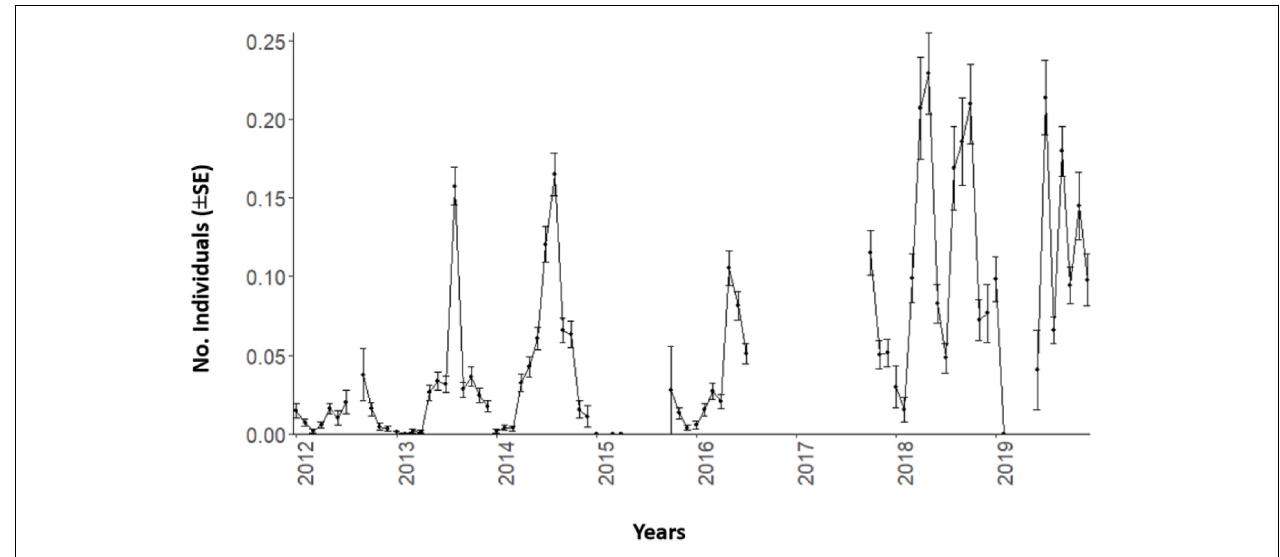
July with 615 counts (16.41%), and finally October with